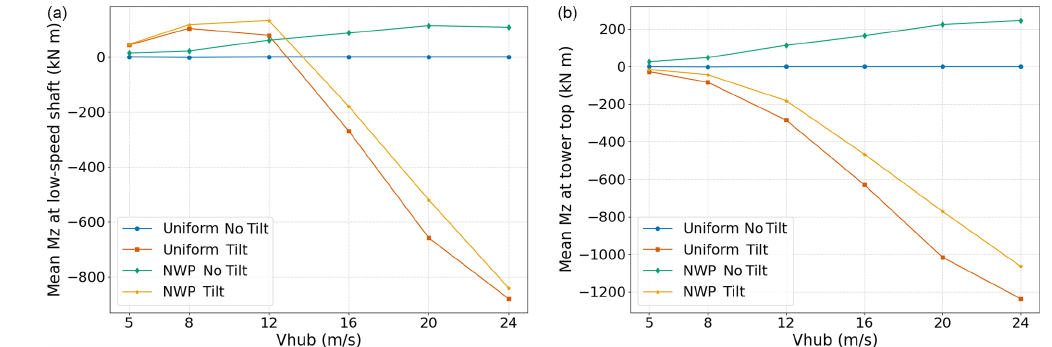
Figure 3. Aerodynamic (a) and total (b) mean yaw moment M z under constant wind speed without tilt (blue), constant wind speed with tilt (orange), NWP without tilt (green) and NWP with tilt